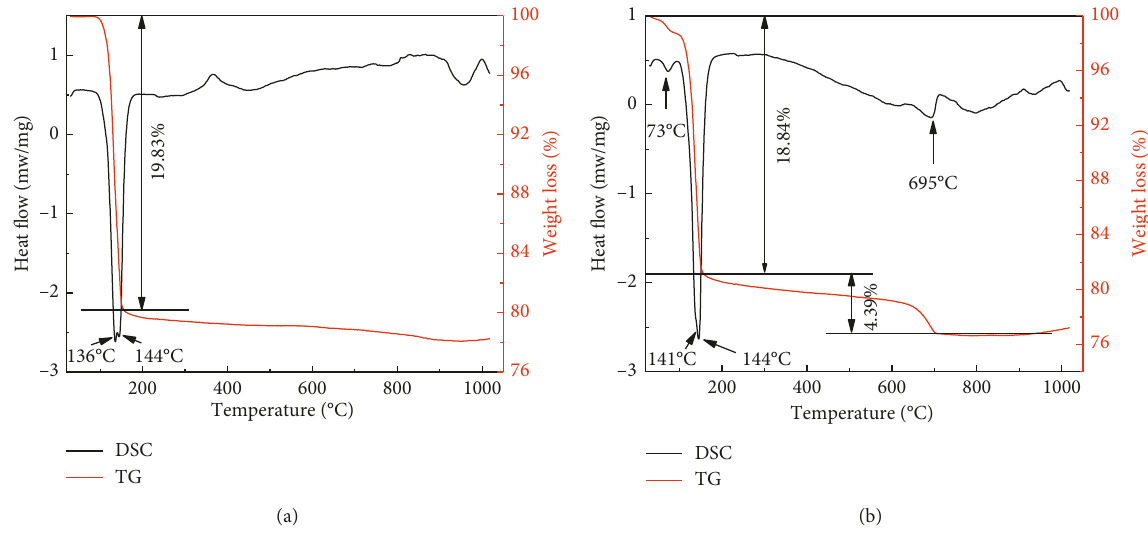
Figure 8: The constituent of hardened R-CP-0 and R-CP-10: (a) DSC/TG of hardened R-CP-0; (b) DSC/TG of hardened